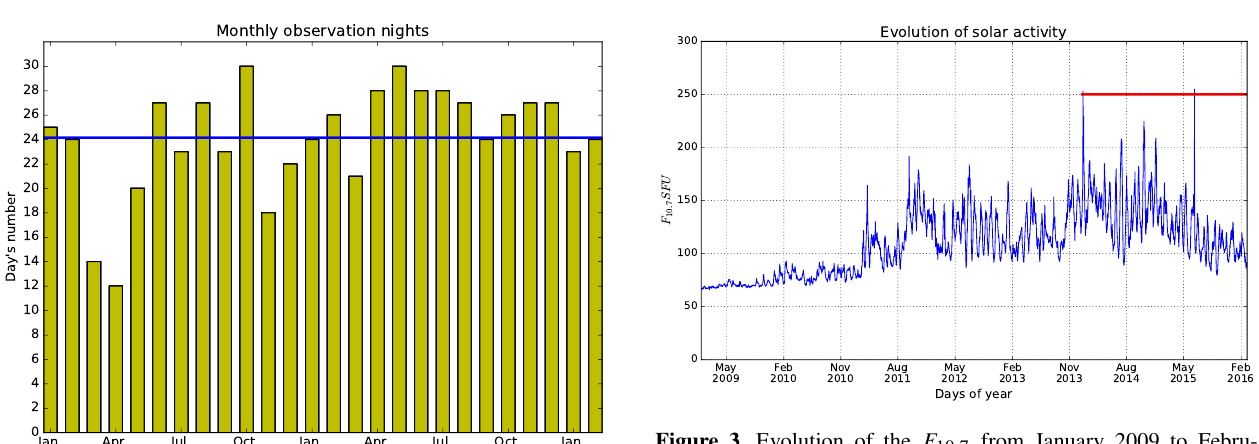
Figure 3. Evolution of the F 10 . 7 from January 2009 to Febru- ary 2016 with the period of available data